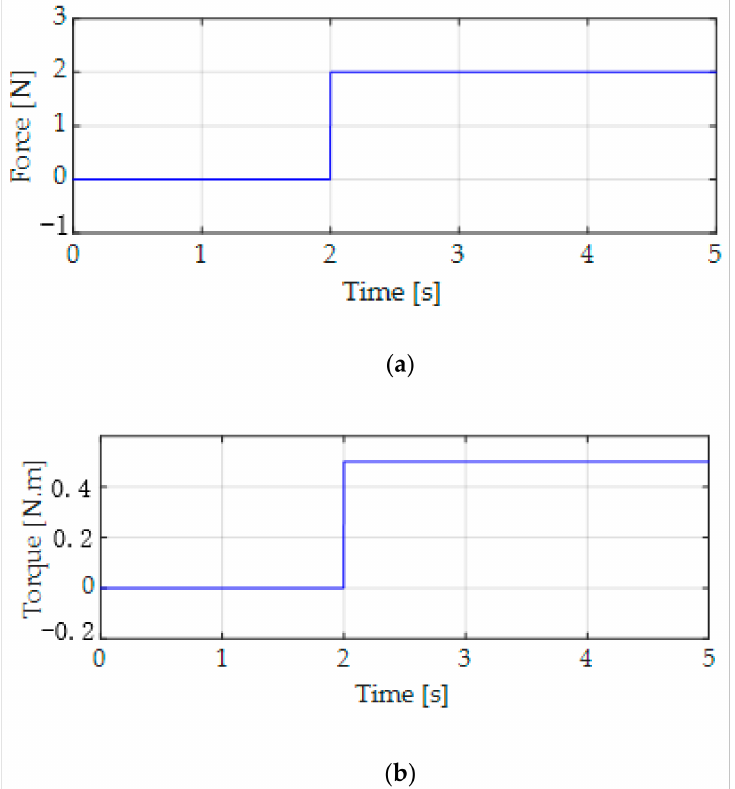
Figure 5. Load forces and load torque. ( a ) Load forces d x and d y ( b ) Load torque d yaw